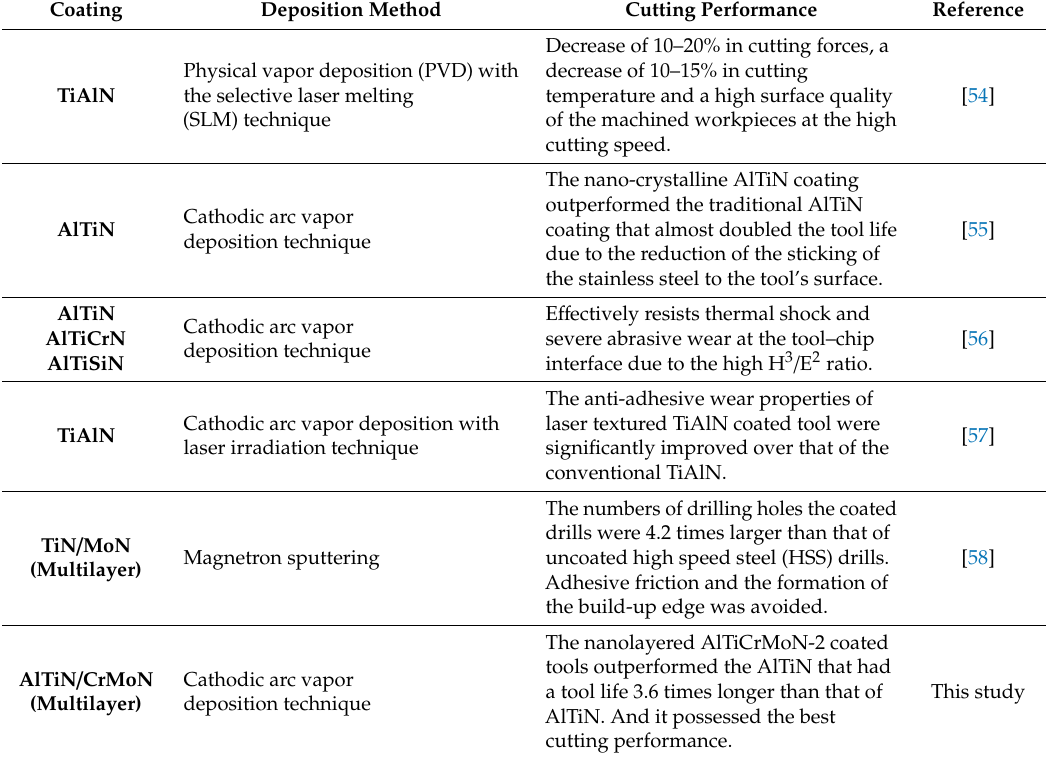
Figure 6. Average flank wear of the AlTiN, AlTiCrMoN-1 and AlTiCrMoN-2 coated end mills for machining SUS316L stainless steel with cutting distances to 82 m. Table 4. Comparison of cutting performance of different coatings for machining austenitic stainless